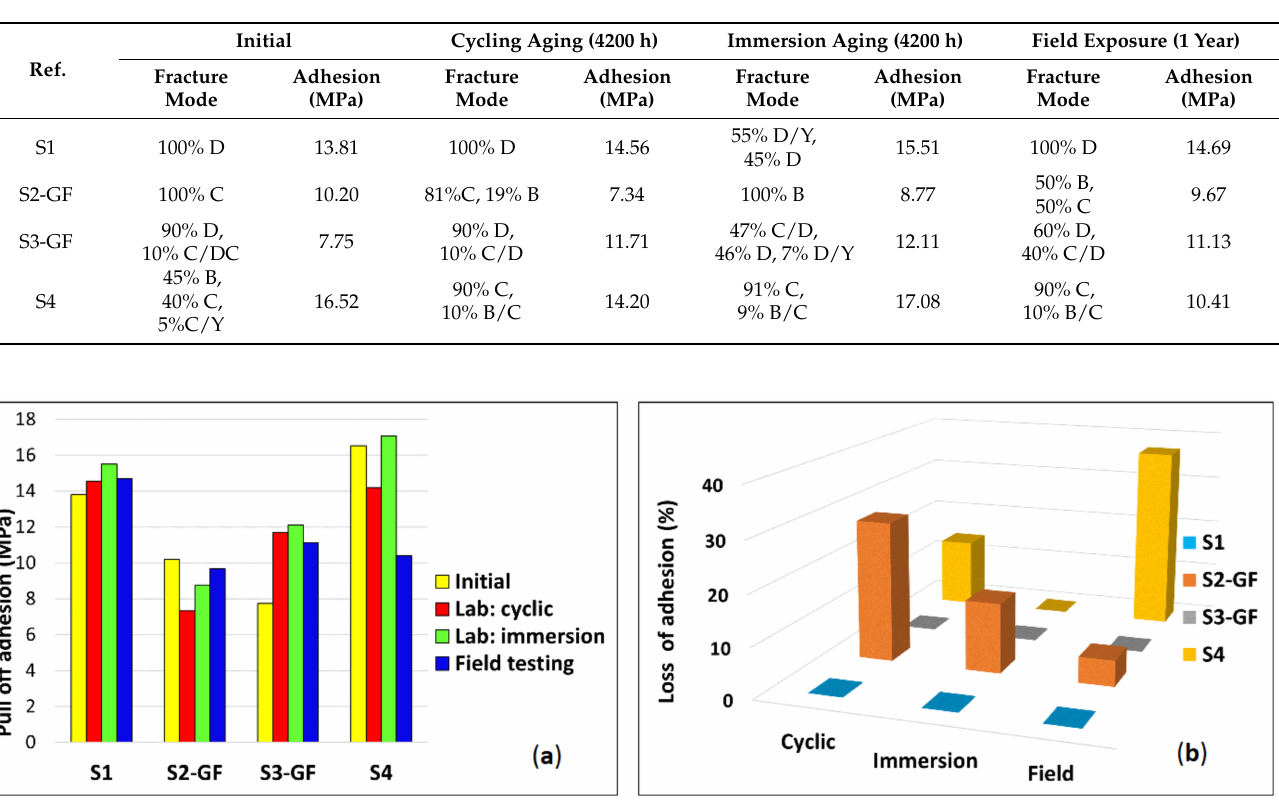
Table 8. Adhesion strength (average) of the coating systems for the splash zone before and after aging and field exposure.